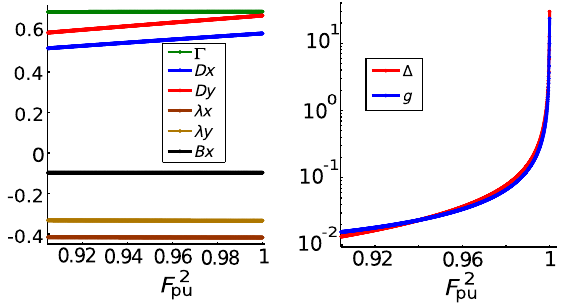
FIG. 10. The aKPZ coefficients for the bad cavity configuration with zero detuning. Left panel: Diffusion coefficients ( D nonlinearities ( λ , λ ), anisotropy parameter ( Γ ), and drift term B x y as a function of the pump power normalized to the upper threshold. These parameters vary little with the external pump power. Right panel: Dimensionless nonlinearity g and noise parameter Δ as a function of the normalized pump power. We observe the asymptotic growth of these parameters close to the upper OPO